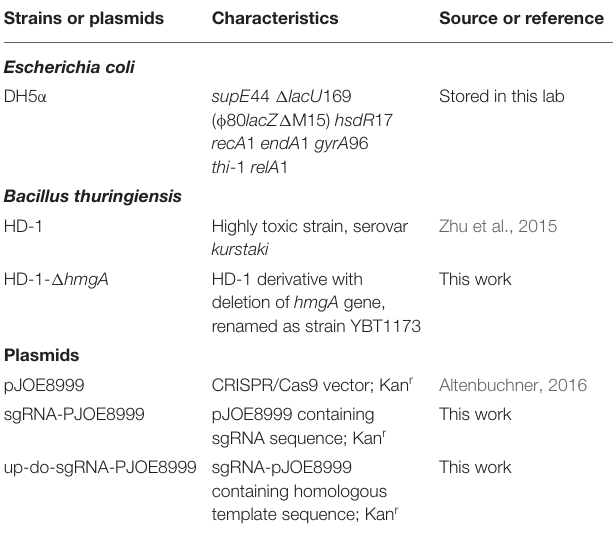
TABLE 1 | Strains and plasmids used in this work.